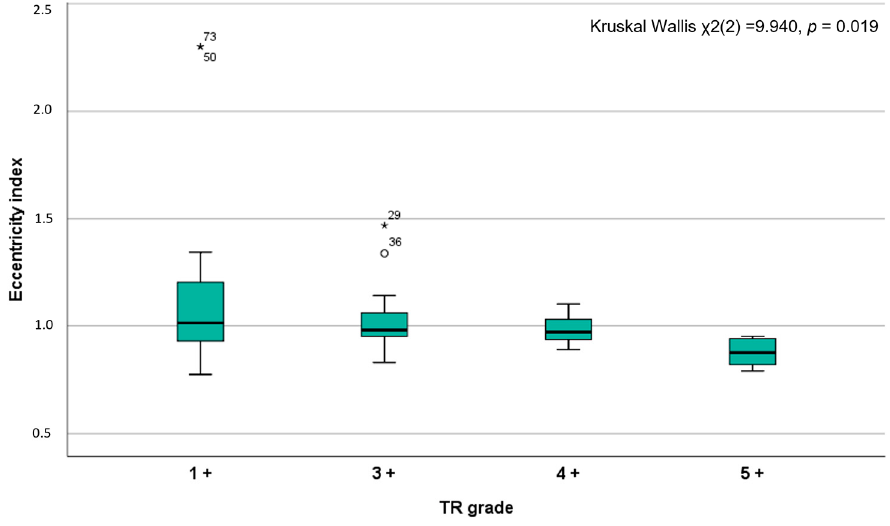
Figure 2. Boxplot showing the distribution of eccentricity values among the expanded tricuspid regurgitation severity grades. TR: tricuspid regurgitation.